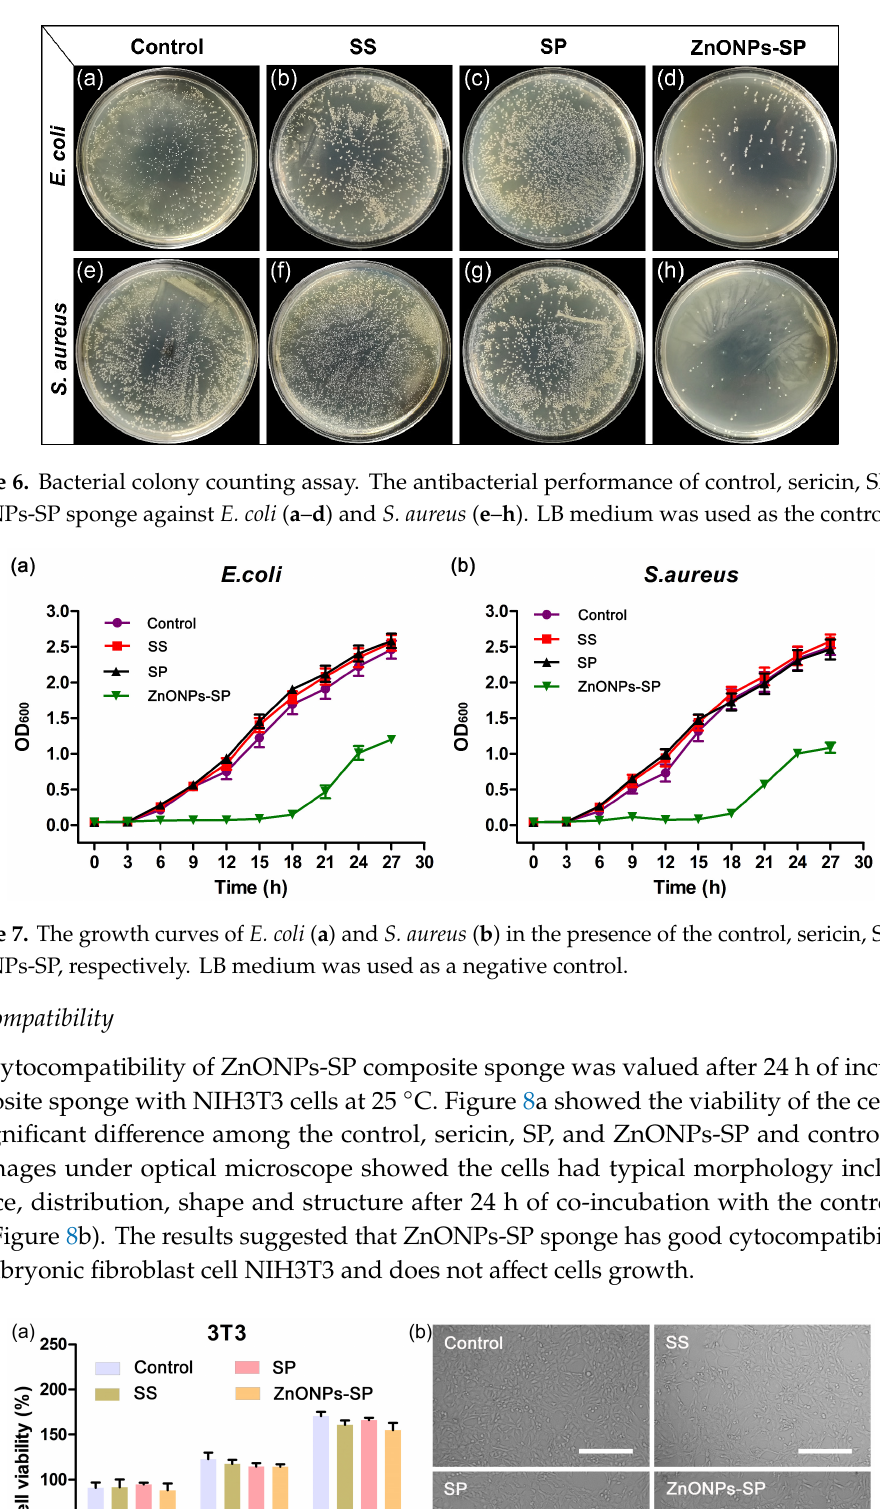
Int. J. Mol. Sci. 2019 , 20 , x